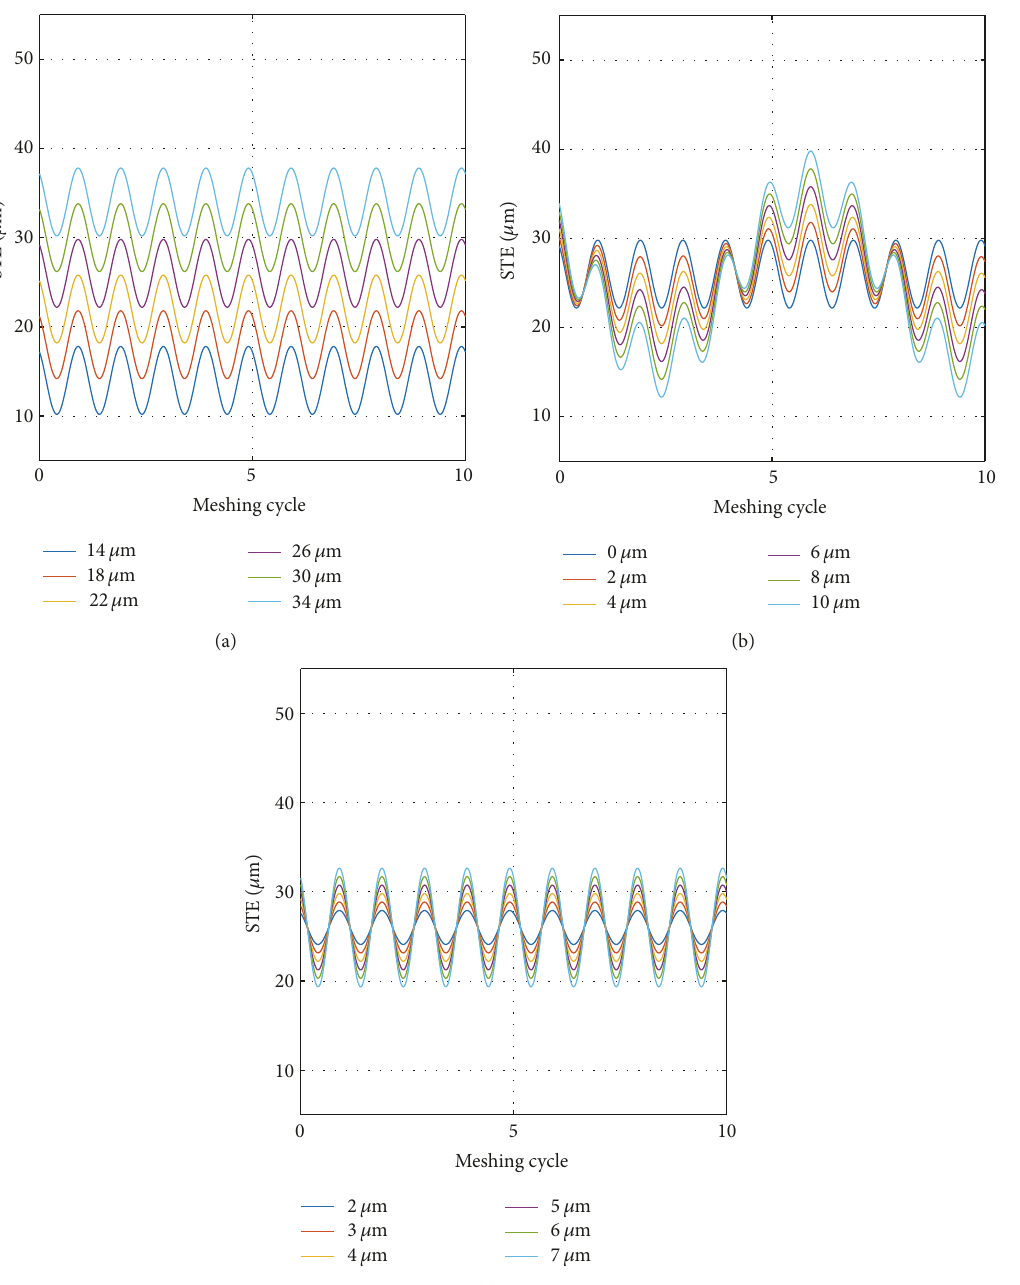
Figure10:PortionsofSTEcurvesanalyticallygeneratedby(a)varyingtheaveragevalueoftheSTE,(b)varyingtheamplitudeoftheharmonic component at the angular frequency of the holes, and (c) varying the amplitude of the harmonic component at the angular frequency of the meshing